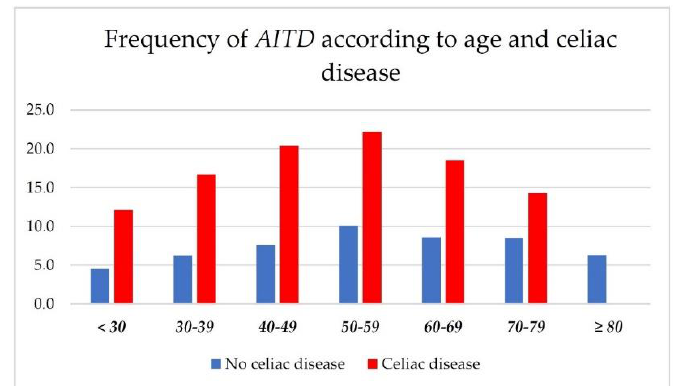
Figure 2. Frequency of autoimmune thyroid disorders (AITD) according to age (by decade) and presence of celiac disease.